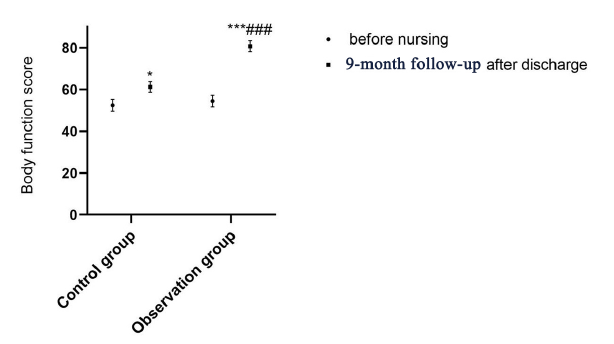
Fig. 5 - Comparison of vitality scores between the two groups before and after continuing care. Compared with on admission within the same group, *P<0.05, ***P<0.001; compared with the control group after continuing care, ### P<0.001.